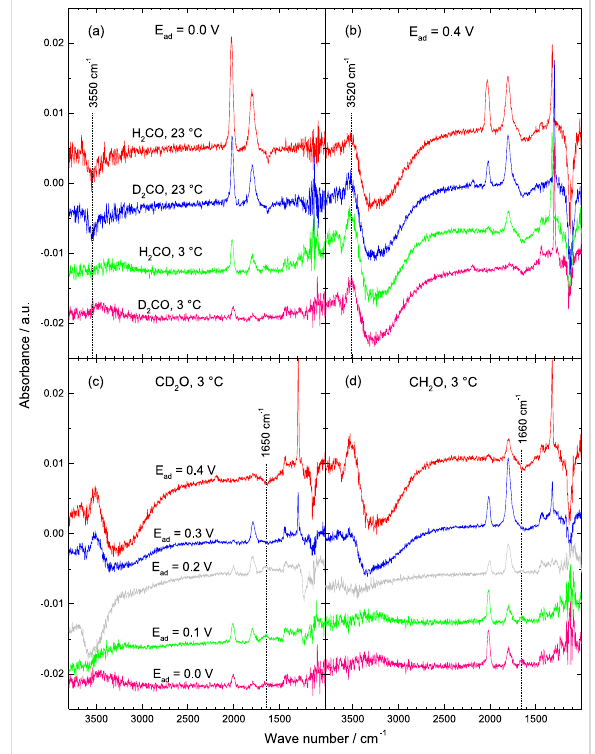
Figure 2: Initial ATR-FTIR spectra acquired ca. 2 s after admission of 0.1 M H2- or D2-formaldehyde solution in 0.5 M HClO 4 to a film Pt electrode at: 0.0 V (a) and 0.4 V (b) at 23 and 3 °C; at 0.0, 0.1, 0.2, 0.3 and 0.4 V for 0.1 M D2- (c) or H2-formaldehyde (d) at 3 °C tempera- ture (see figure for notations).